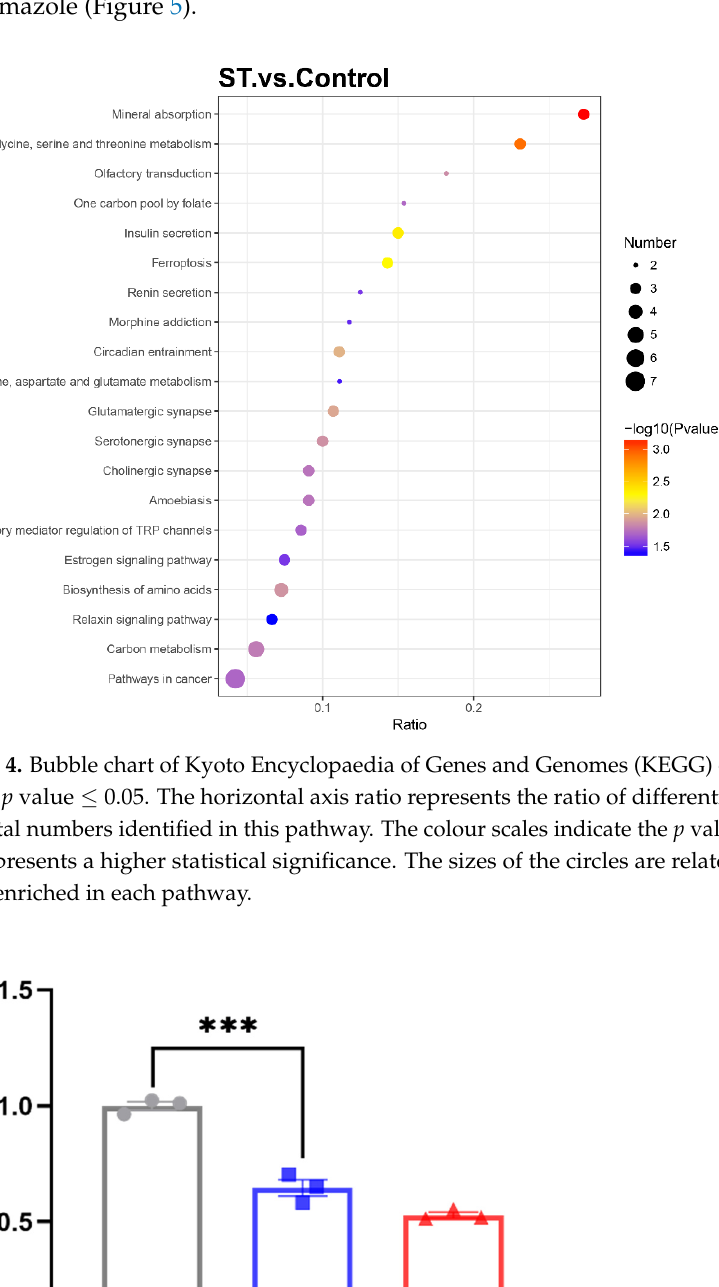
Table 6. The six potential targets of stemazole combined with diseases databases.